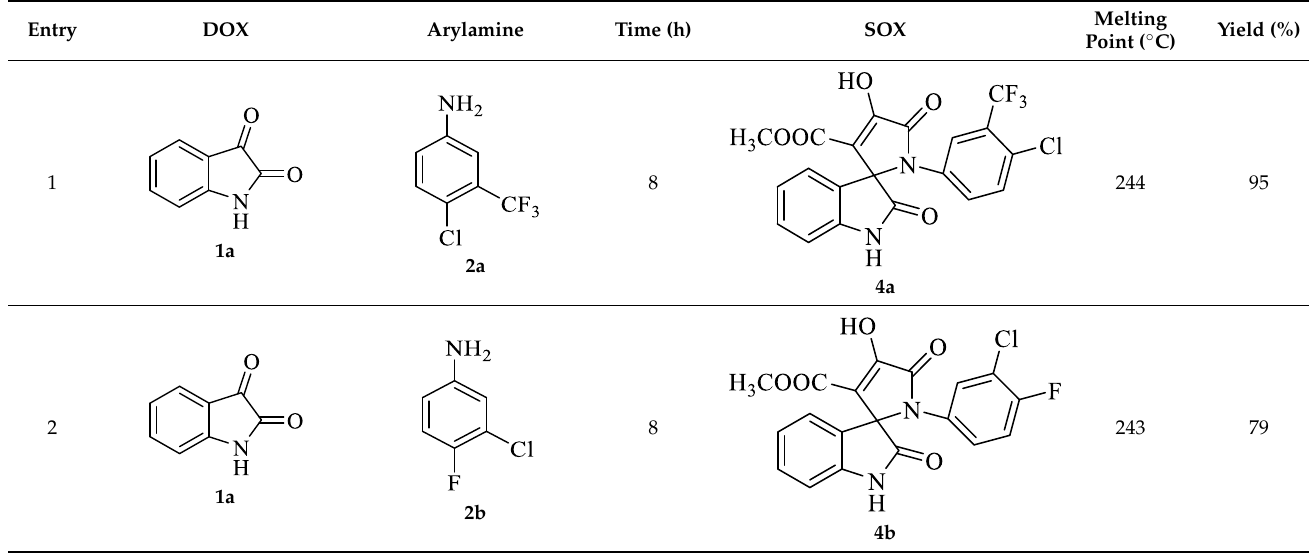
Table 2. Synthesis of SOXs ( 4a – h ) from substituted DOX ( 1a-c ), dimethyl acetylenedicarboxylate 3, and aryl amine ( 2a - c ).